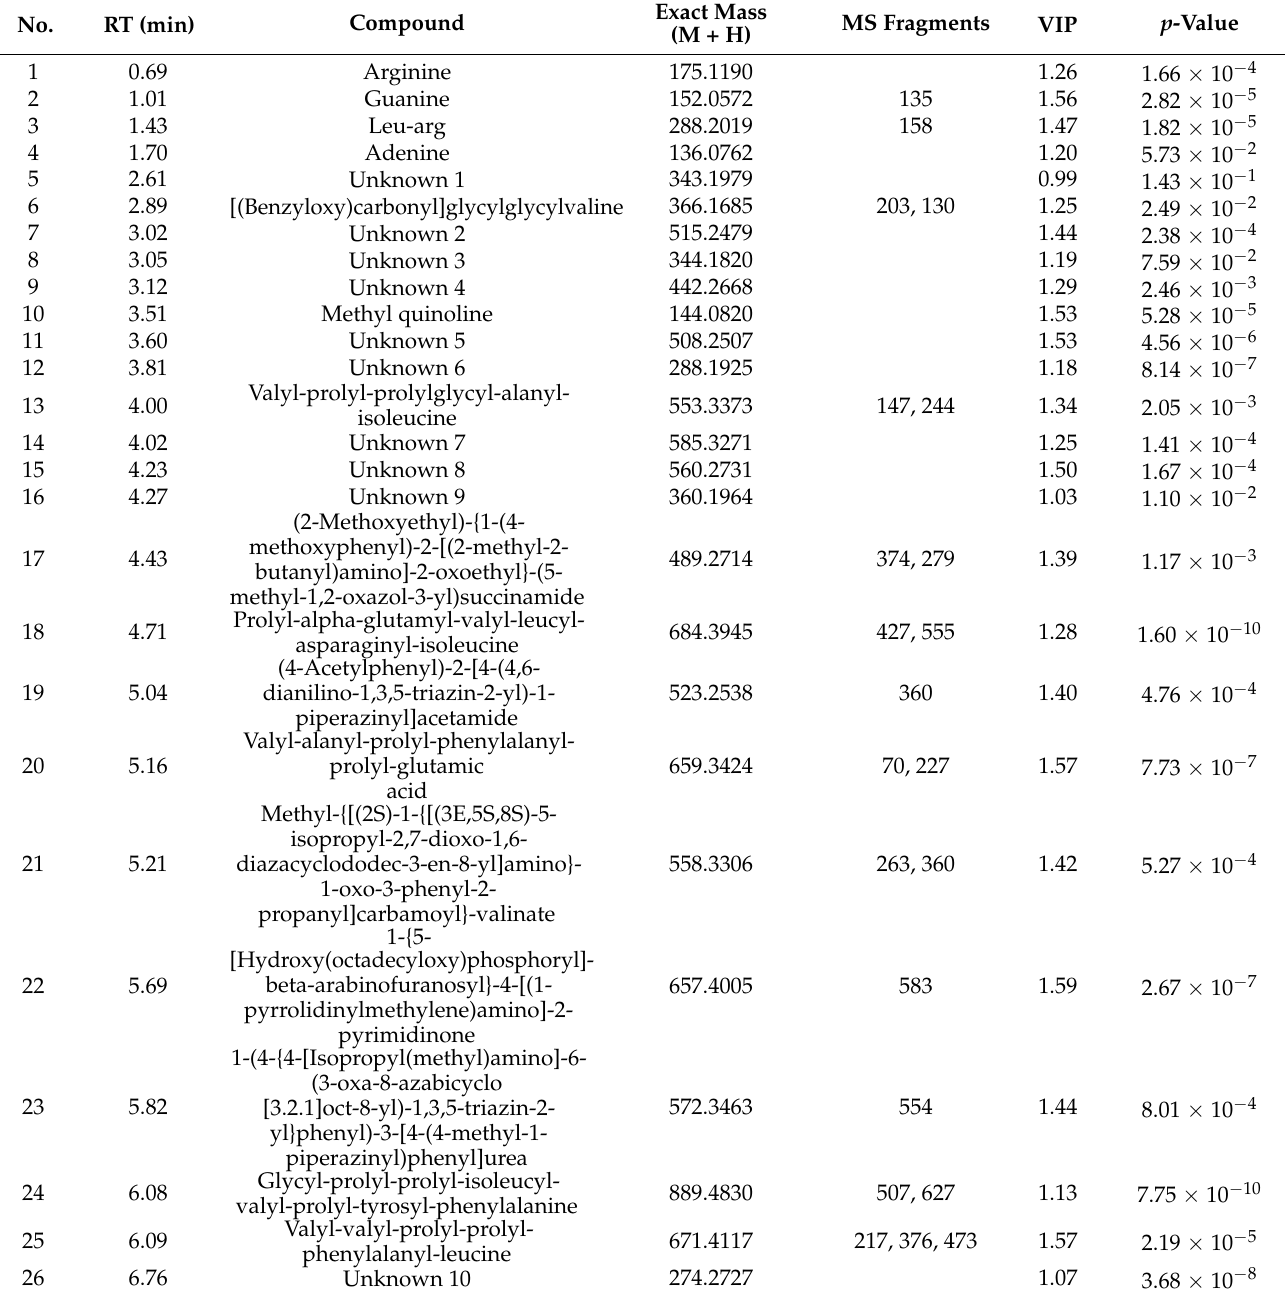
Table 3. Identification of major metabolites contributing to separation among the sample